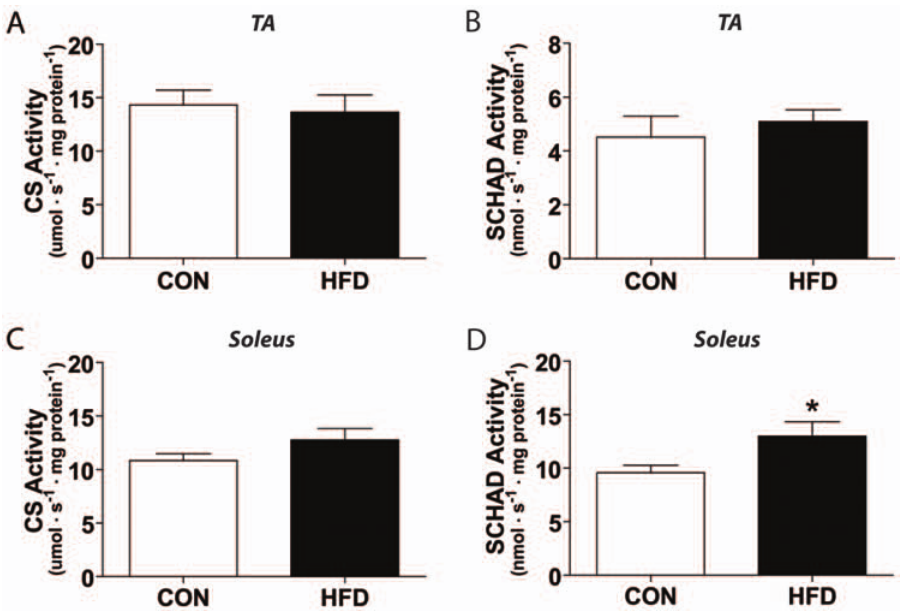
Figure 5. Oxidative enzyme alterations are muscle specific. Citrate synthase (CS) activity is unaltered in both (A) TA and (C) soleus muscle between control (CON) and high fat diet (HFD). Short chain 3- b -hydroxyacyl coenzyme-A dehydrogenase (SCHAD) activity is unaltered in (B) TA muscle, though (D) soleus muscle from HFD mice exhibits SCHAD activity 136% of CON. Significance is represented by * vs. CON, p , 0.005.